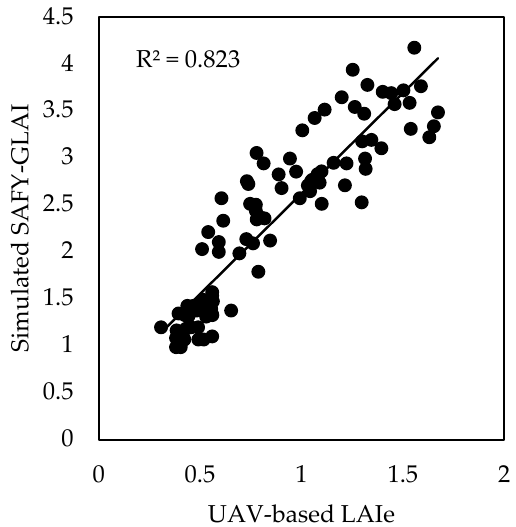
Figure 9. Relationship between the simulated SAFY-GLAI and UAV-based LAIe for 32 sampling locations in S2.